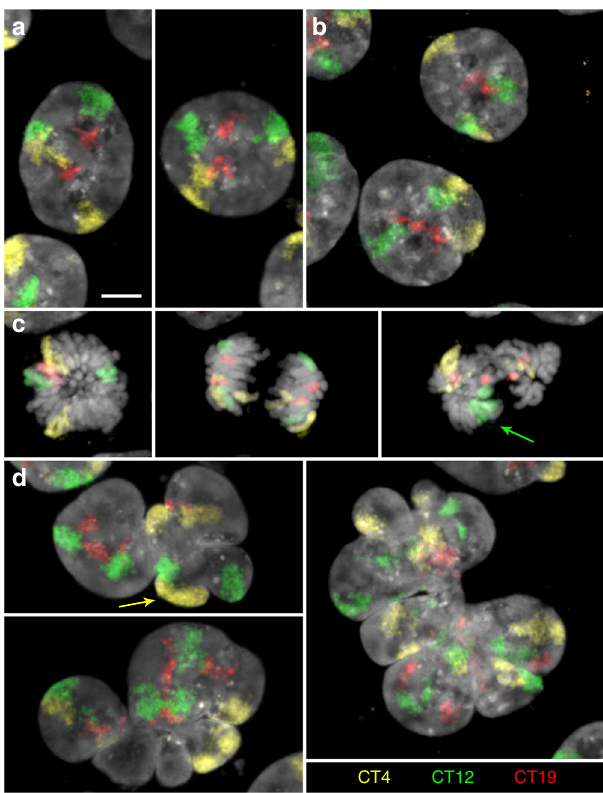
Fig. 2 Maintenance of chromosome territories (CTs) in cohesin depleted nuclei and their reconstitution after endomitosis. a – d Z-projections of entire DAPI-stained nuclei (gray) with painted territories of chromosomes 4 (CT4, yellow), 12 (CT12, green) and 19 (CT19, red) acquired by confocal fl uorescence microscopy. a control nuclei and b pre-mitotic cohesin depleted nuclei after 6 h in auxin show two inconspicuous copies for each CT. c Mitoses from 6 h auxin-treated cultures with two coherent chromosomes in a (presumably early) metaphase plate (left), after chromatid segregation (mid) and missegregation of chromosome 12 (arrow) in an abnormal mitotic fi gure (right). d left: two endomitotic multilobulated nuclei (MLN) with four copies for each CT. Arrow marks two CTs 4 that are overlayed in the z-projection. Right: Large MLN with a torn- up appearance of CTs with seemingly >4 painted regions for each CT (compare also Supplementary Fig. 4). Scale bar: 5 µ m. Images shown in a – d show representative nuclei from two independent